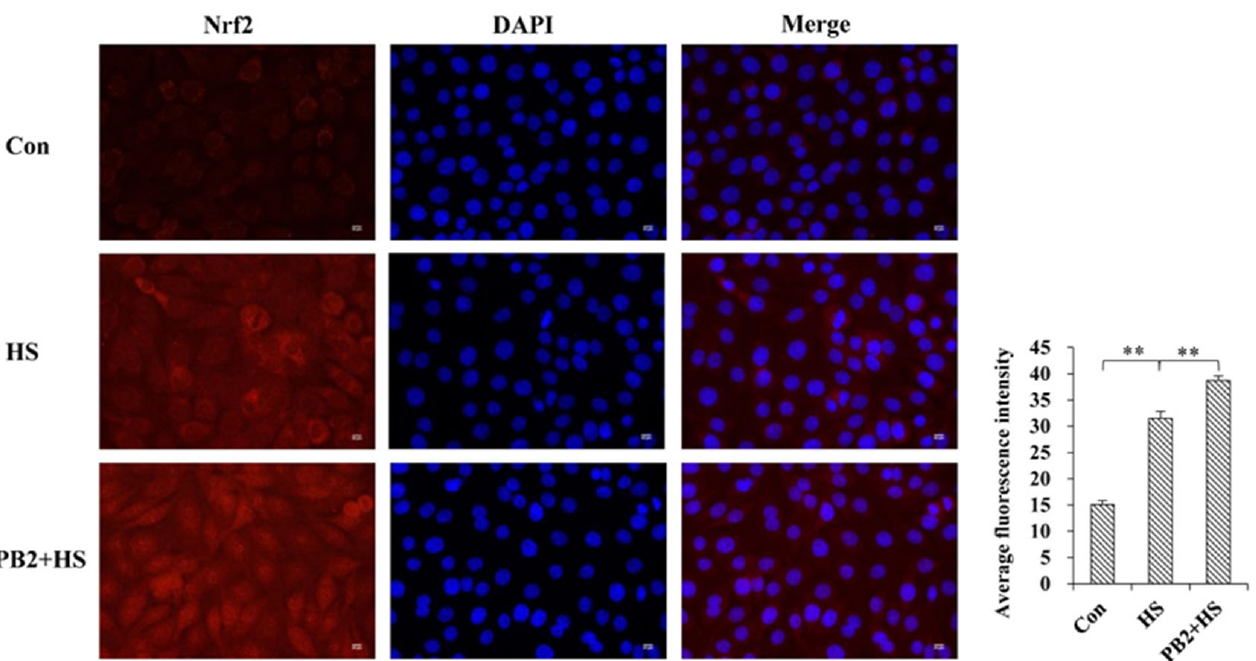
Figure 5. Immunofluorescence confocal microscopy analysis of Nrf2 on its nuclear localization in MAC-T cells. MAC-T cells were pretreated with or without 25 µ M PB2 for 24 h, followed by HS treatment for 3 h and recovery for 6 h. Then, cells were stained with anti-Nrf2 antibody (red) and nuclei with DAPI (blue). Experiments were performed three times and representative immunofluorescence images are shown. Relative florescence intensity assay was performed to determine colocalization of Nrf2 with the nucleus. Normalized values are plotted. n = 3. Scale bar: 50 µ m. ** p < 0.01.